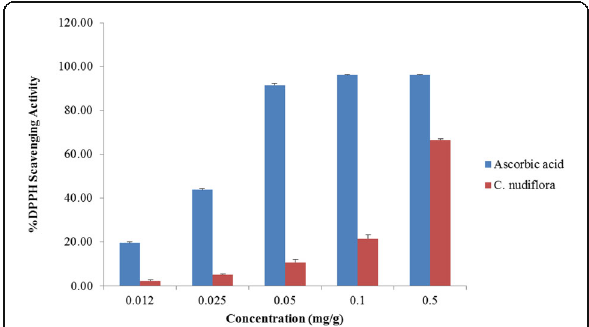
Fig. 1 Free radical scavenging capacity of the methanol extract of